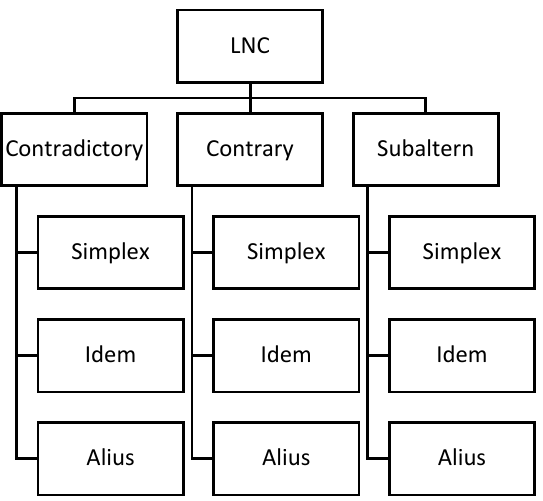
Figure 4. Classification of contradictions.